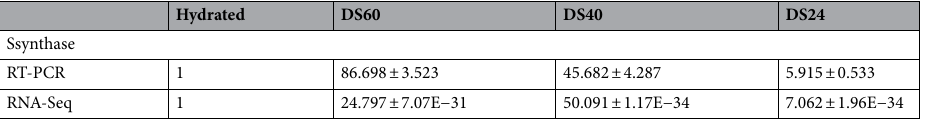
Table 1. RT-PCR and transcriptome RNA-Seq data showing fold 2 change of stachyose synthase genes expressed during dehydration in Tripogon loliiformis shoots. Analysis done in three replicates and analysed at p < 0.05 using R Studio DESeq 2 version 3.11 https:// bioco nduct or. org/ packa ges/ relea se/ bioc/ html/ DESeq2. html. Cells denoted in red and green represent increase and decrease in transcript accumulation respectively in comparison to hydrated